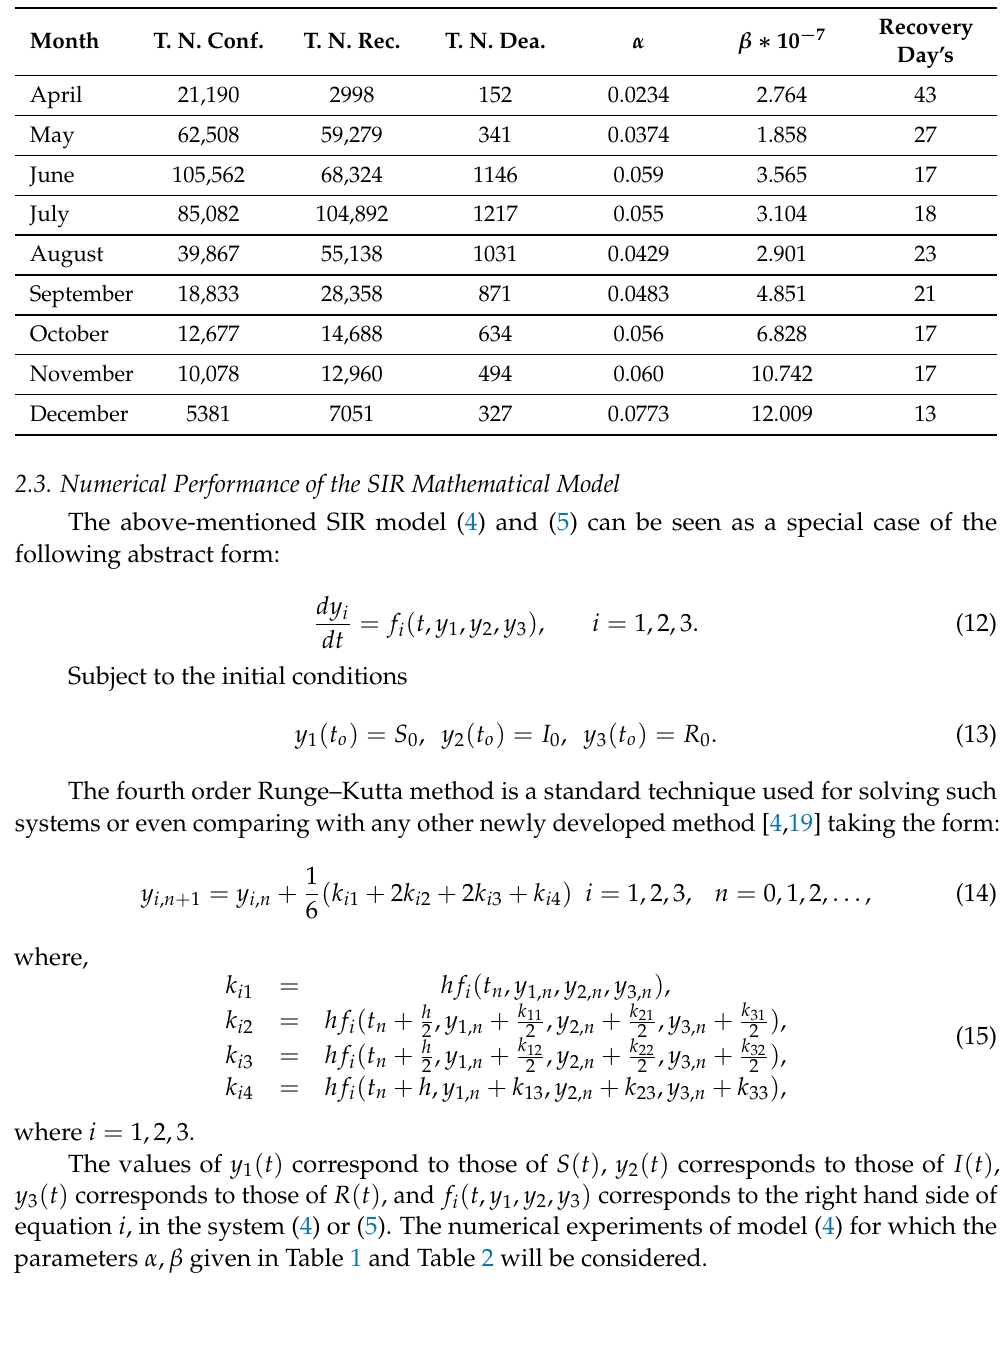
Table 1. Total number (T.N.) of confirmed cases, T.N. of recover cases, T.N. of